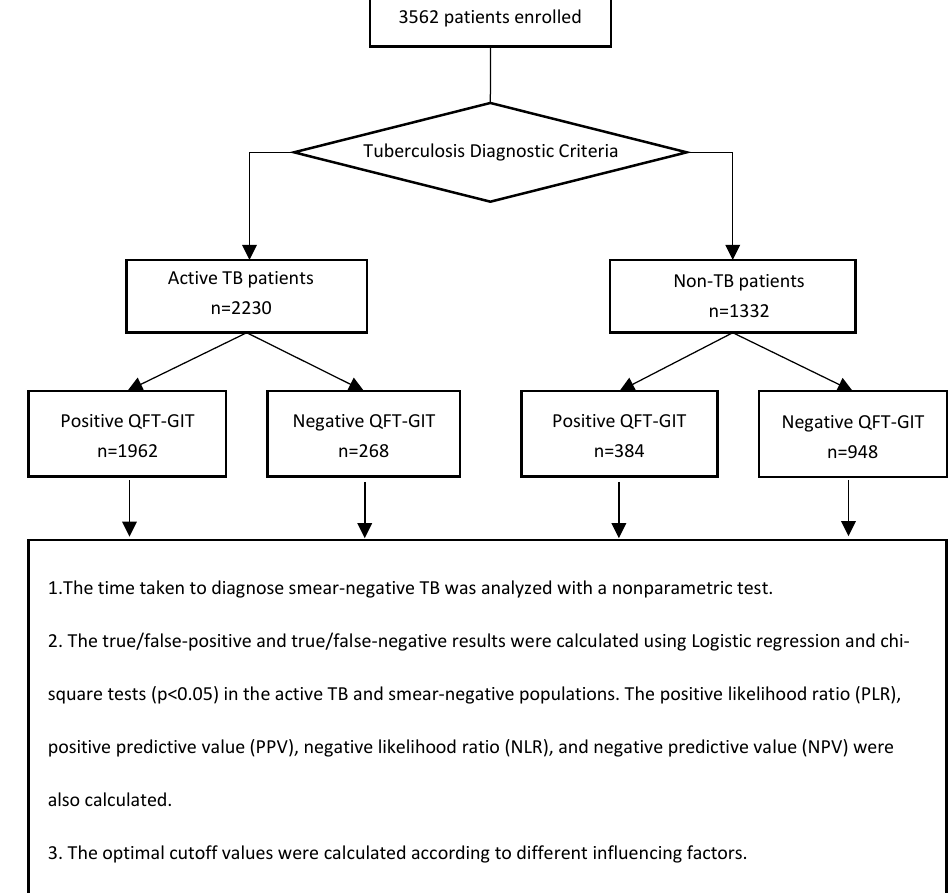
Figure 1. Initially, 3725 patients who underwent QFT-GIT tests from May 2016 to May 2017 were retrospectively analyzed. After excluding 163 cases, a total of 3562 patients were enrolled in the study. n, number.